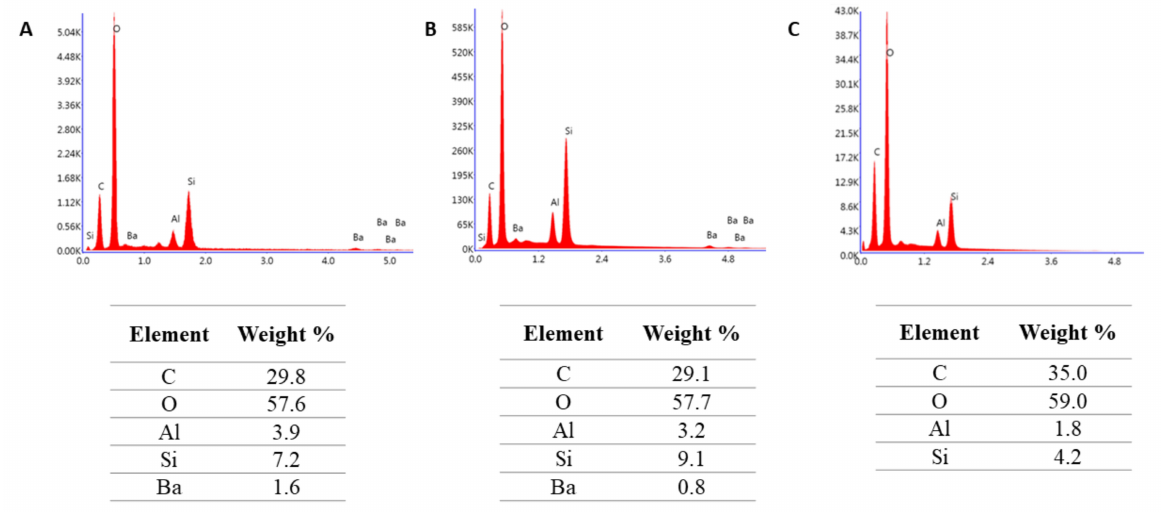
Figure 3. Chemical composition analysis of Arkon material after ( A ) Protocol 1 (24 h, 37 ◦ C, distilled water), ( B ) Protocol 2 (three months, 37 ◦ C, artificial saliva), ( C ) after Protocol 5 (1 week, 60 ◦ C, 0.1 M NaOH). Data were obtained by energy dispersive spectroscopy